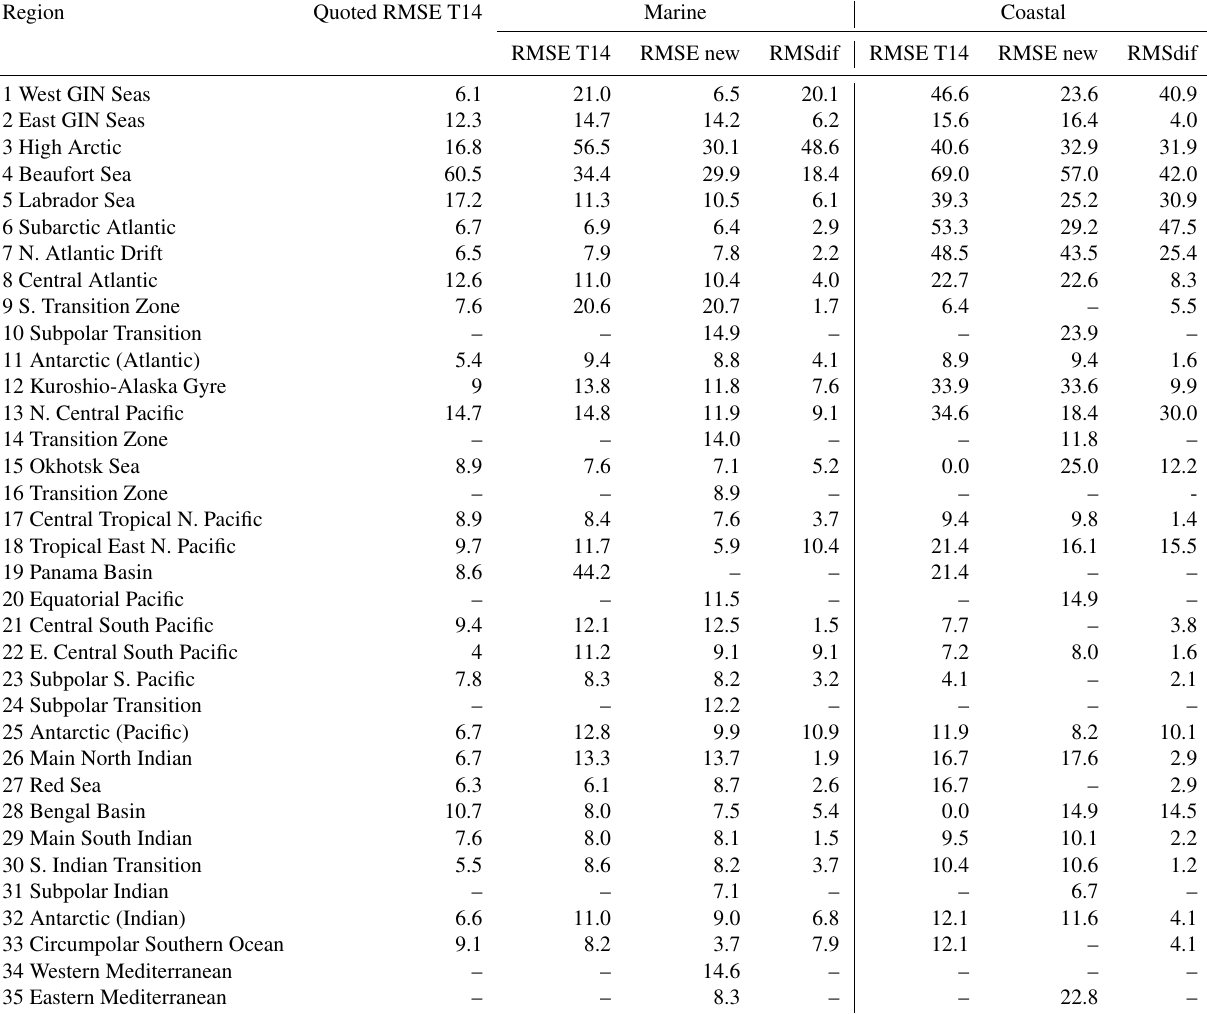
Table 2. Quoted and calculated RMSE values in each region defined by Takahashi et al. (2014) (T14) partitioned into coastal and marine subregions (see Table 3 for definitions). Calculated values are for the original T14 coefficients (RMSE T14), the coefficients recalculated using the MDB with cross-validation (RMSE new) and the RMS difference between the two over the MDB data (RMSdif). Region Quoted RMSE T14 Marine Coastal RMSE T14 RMSE new